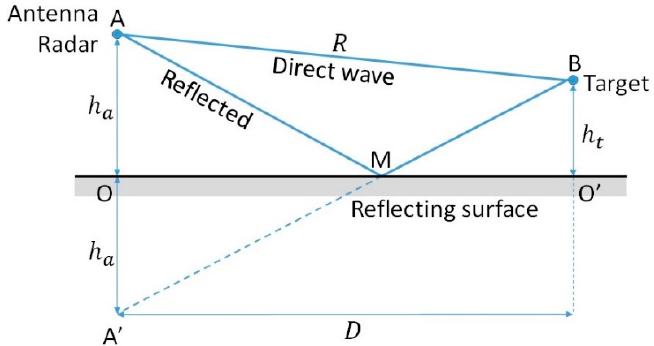
Figure A1. Geometry of the radar propagation on a plane-reflecting surface.